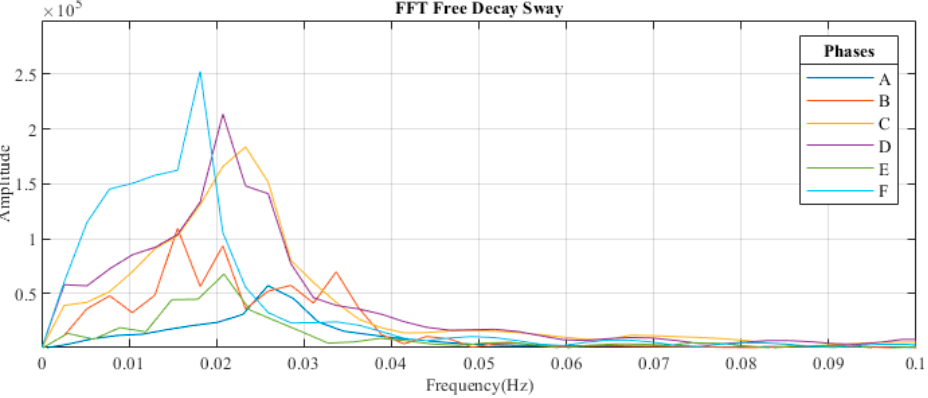
Figure 9. FFT of free decay of sway motion for all phases of testing.